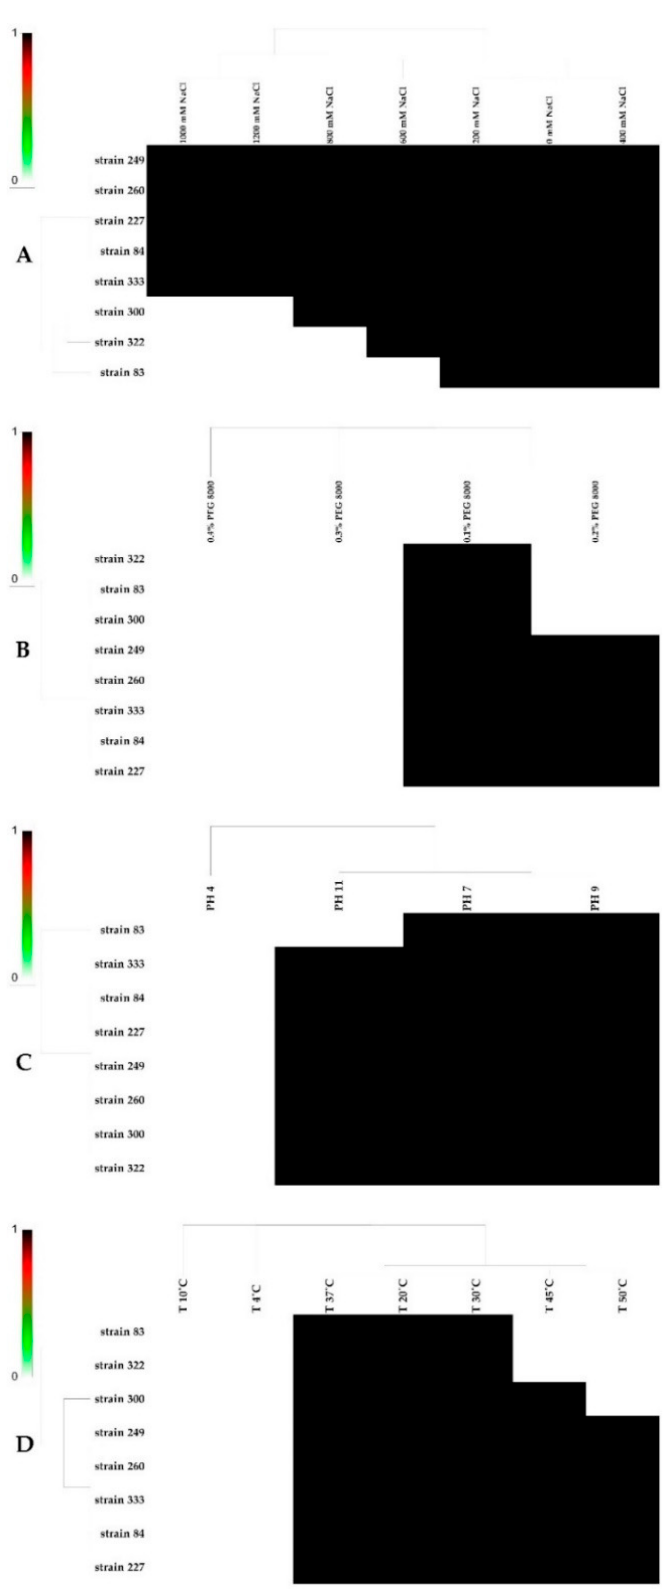
Figure 10. ( A ) Effects of different concentrations of NaCl, ( B ) PEG 8000 , ( C ) PH values, and ( D ) temperature on the growth of bacterial strains.